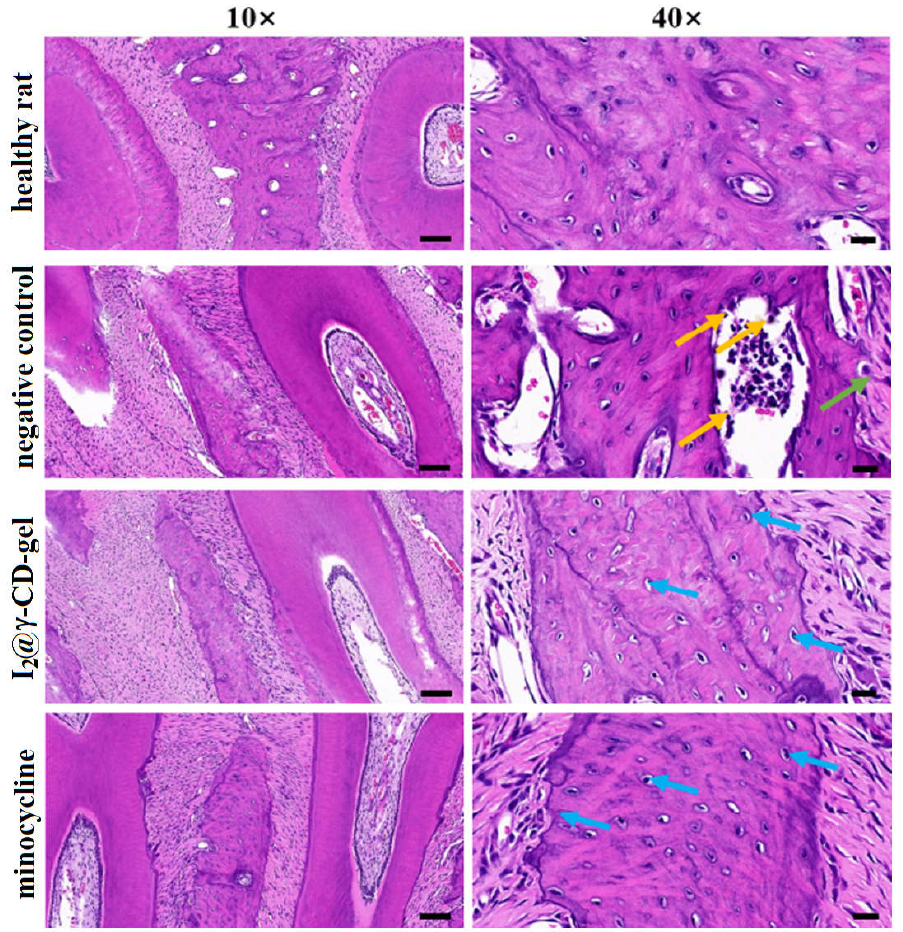
Figure 7. Histology of the left upper jaw of rats in the normal periodontium (upper line), periodontitis-induced (negative control, second line from the top), minocycline treatment group (third line), and the group treated with iodine-loaded gel (I 2 @ γ -CD-gel, bottom line). Samples were stained using the H&E (hematoxylin and eosin) dye mixture. Green, blue and orange arrows represent infiltrated inflammatory cells, osteoblasts and osteoclasts, respectively. Scale bar represents 100 µ m, 20 µ m for 10 × , 40 × , respectively. Reprinted with permission from Lu et al . [44] (Copyright 2021, Elsevier